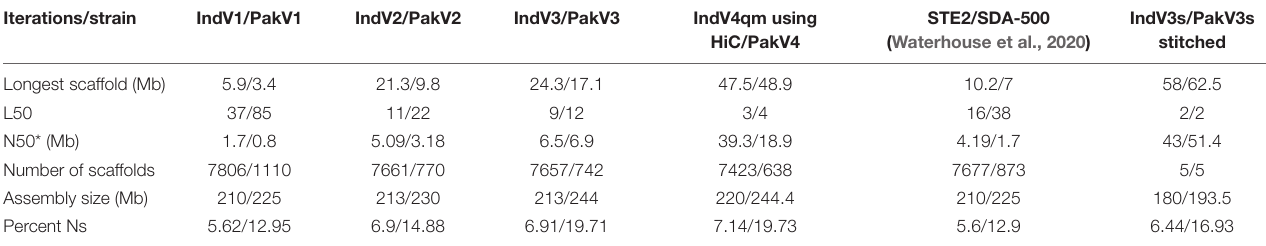
TABLE 1 | Homology-based iterative assembly.